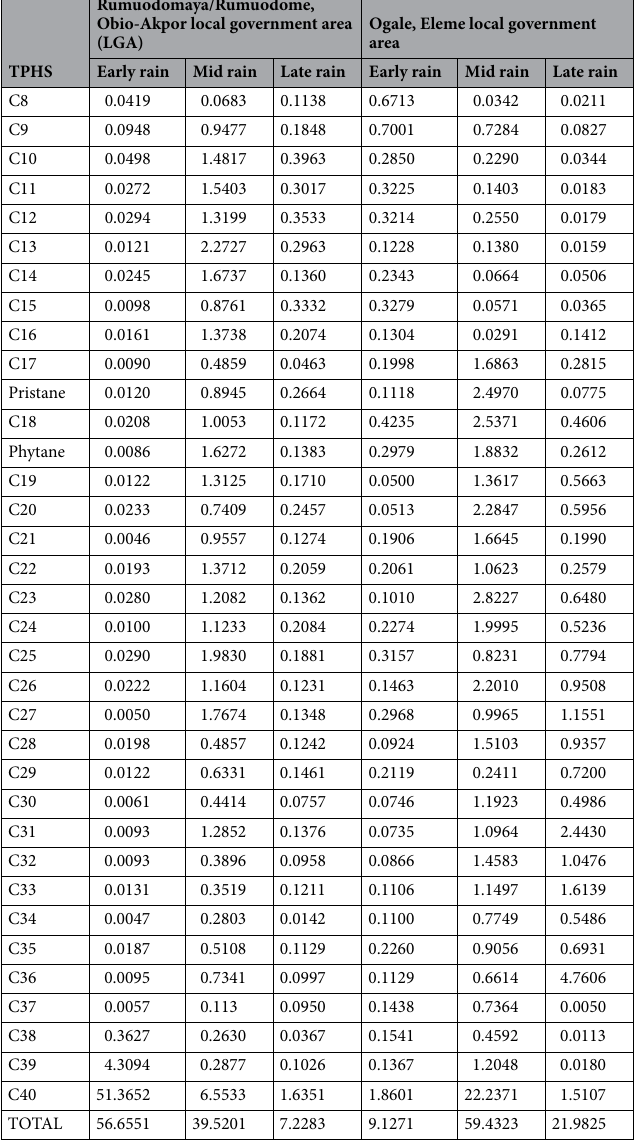
Table 3. Mean concentration of TPHs determined in rainwater samples. N =